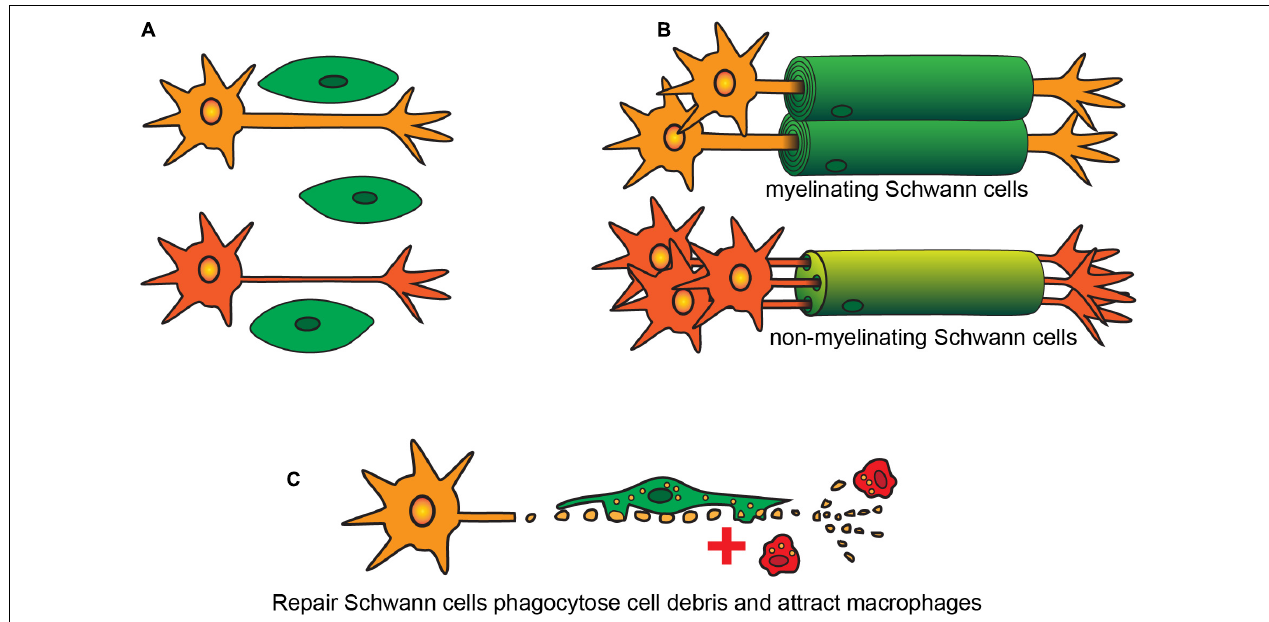
FIGURE 1 | Developmental stages and types of SCs. (A) Immature SCs originate during embryogenesis and interact with different sized axons. (B) SCs become either myelinating or non-myelinating type depending on the size of the axons. (C) After injury both myelinating and non-myelinating SCs revert into a repair phenotype to phagocytose cell debris and to recruit